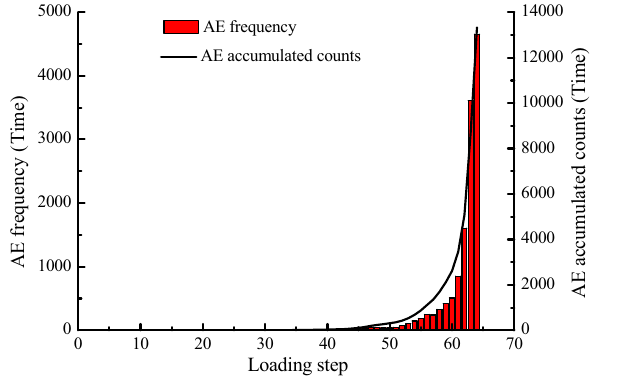
Figure 10. AE curve of numerical